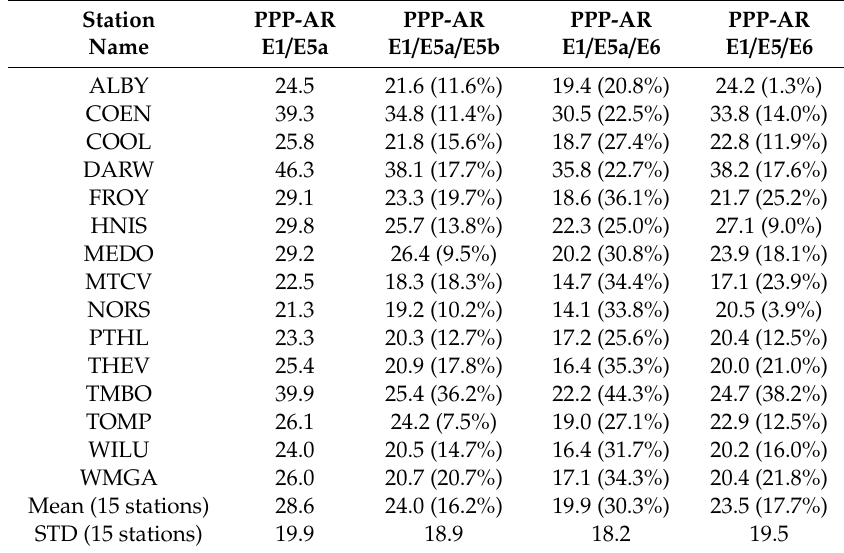
Table 5. Mean convergence time (min) of dual-frequency (E1 / E5a) and triple-frequency (E1 / E5a / E5b, E1 / E5a / E6, and E1 / E5 / E6) PPP-AR with the pilot Galileo receiver antenna corrections for solutions with respect to each station. The reduction rate of the convergence time of triple-frequency PPP-AR relative to dual-frequency PPP-AR is shown in